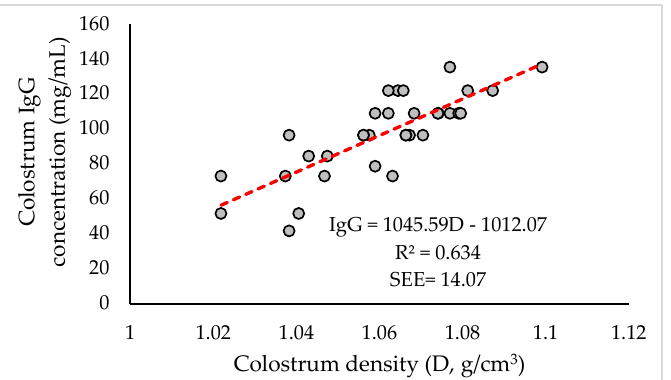
Figure 4. Relationship between IgG concentration (mg/mL) and density (D, %) in the colostrum of Merino Precoz ewes.